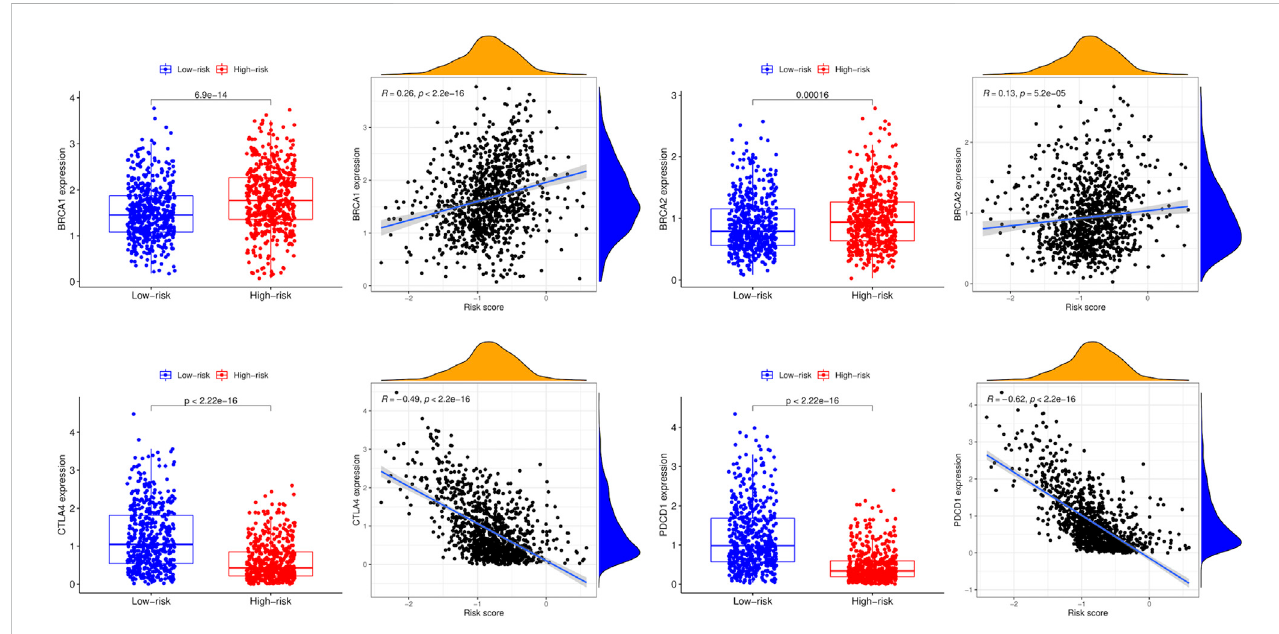
FIGURE 9 Correlations between breast cancer-related genes and the risk score.